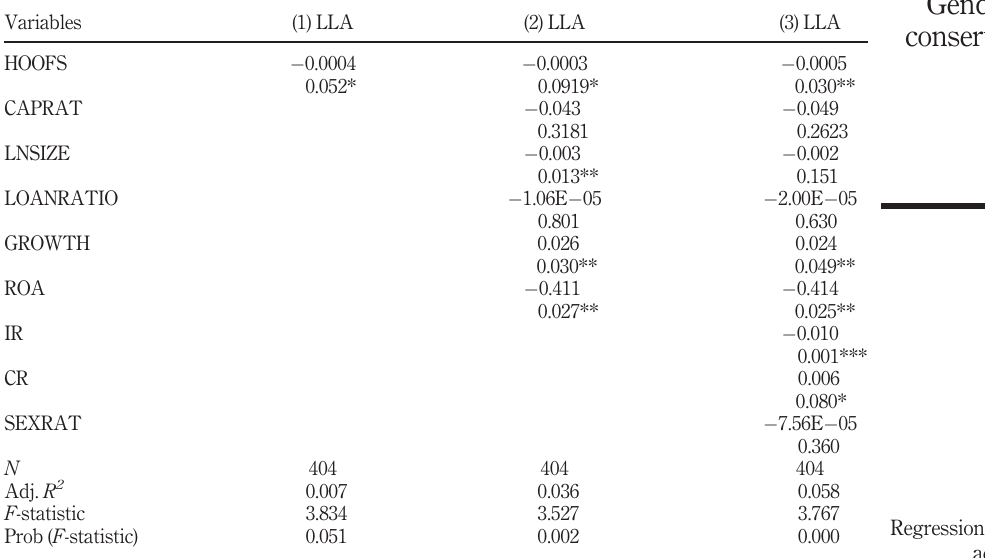
Table 7. Regression result